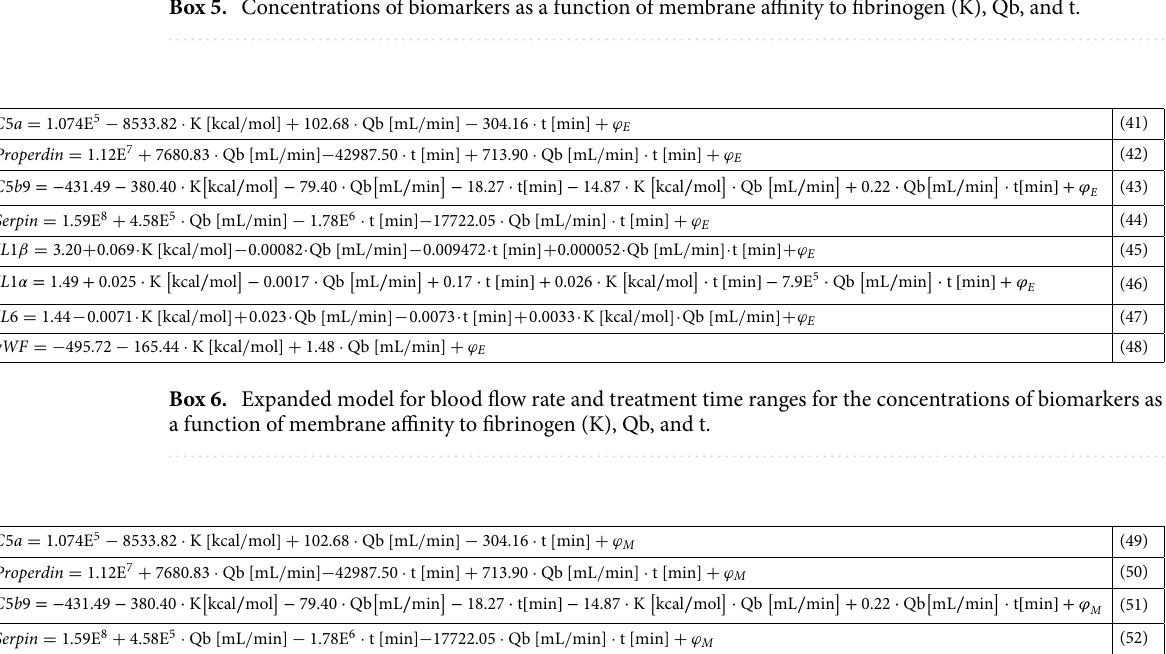
Box 5. Concentrations of biomarkers as a function of membrane affinity to fibrinogen (K), Qb, and t.